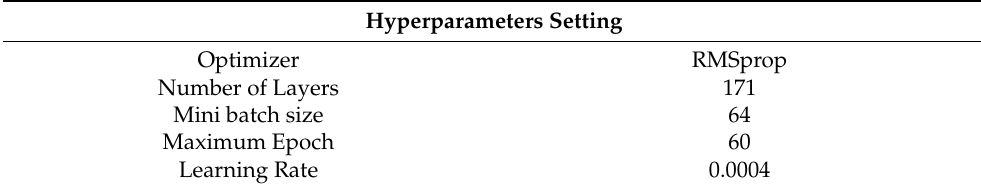
Table 1. Pre-trained ShuffleNet hyperparameters setting.